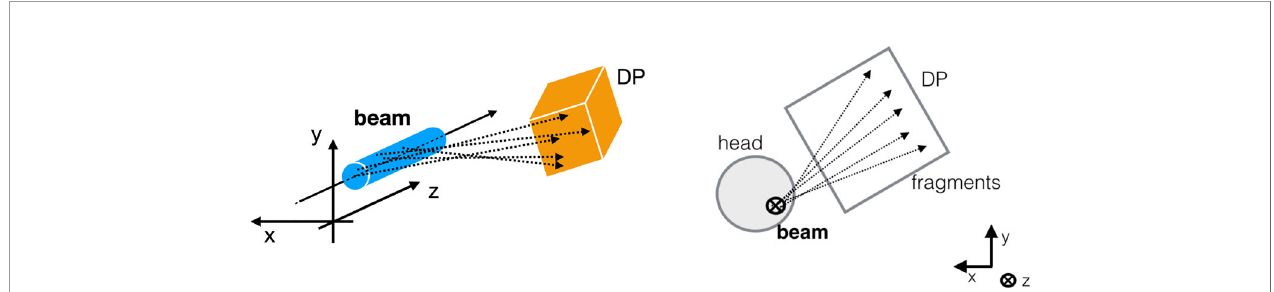
FIGURE 1 | Sketch of the experimental setup. On the left a 3D sketch is showing the measurement principle: the production point of the fragments (dashed lines) detected by the DP are all located around the transverse beam position, within the beam lateral size (cyan cylinder). On the right the 2D projection is shown from the perspective in which the beam (black bold cross) is orthogonal to the picture. The rationale of the strategy proposed in the manuscript can be observed: in the plane orthogonal to the beam direction, the tracks intersections can be used to identify the beam incoming direction in the x,y